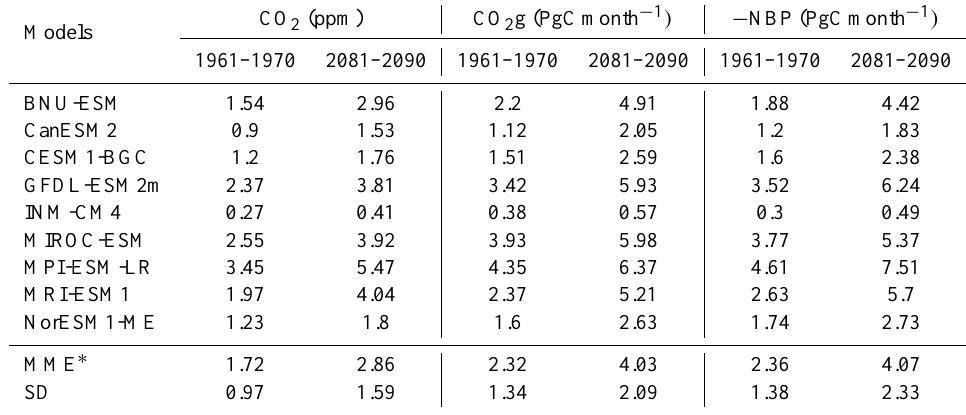
Table 2. Amplitude (maximum minus minimum) of global mean column atmospheric CO 2 , CO 2 growth rate (CO 2 g) and global total NBP, averaged over 1961–1970 and 2081–2090 for the nine models, and their multi-model ensemble (MME) and standard deviation (SD).